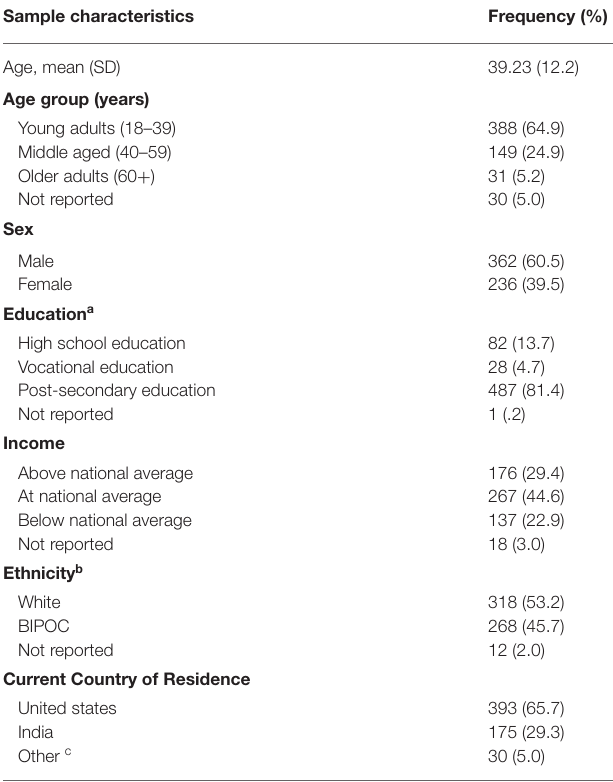
TABLE 1 | Demographic characteristics of